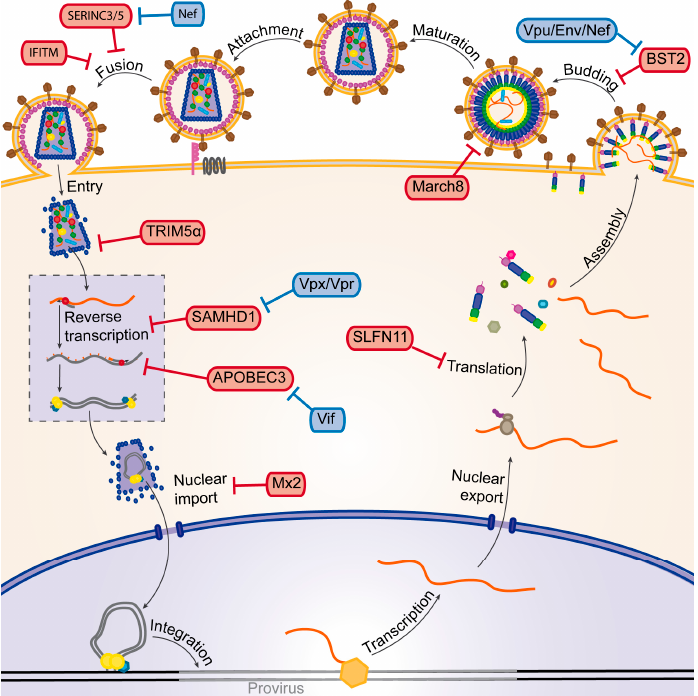
Figure 2. Schematic representation of the HIV-1 life cycle. The main HIV-1 restriction factors and the viral auxiliary proteins that counteract these factors (represented by T bars) are highlighted in red and blue boxes, respectively. See text for a description of the different steps of the life cycle.